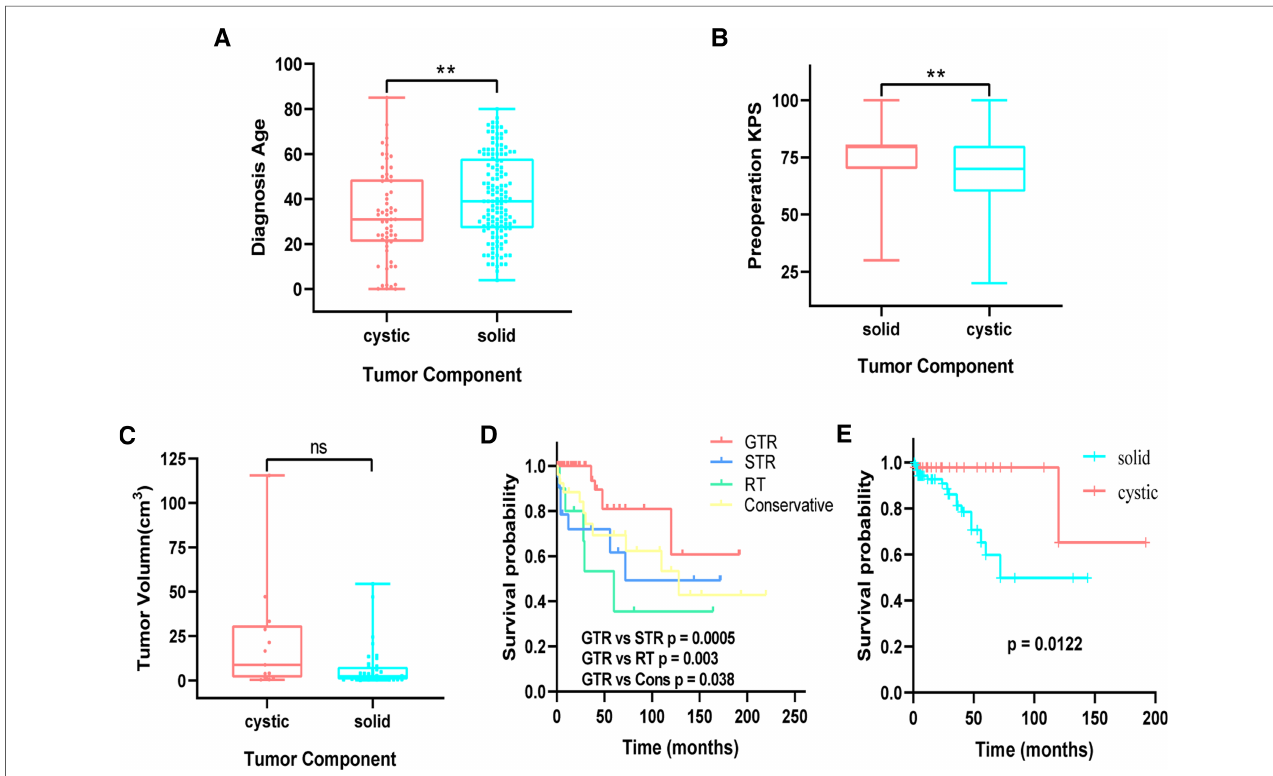
FIGURE 2 ( A ) comparison of age between cystic and solid patients. ( B ) Comparison of preoperation KPS between cystic and solid patients. ( C ) Comparison of cystic and solid tumor volume in purely supratentorial solitary hemangioblastoma. ( D ) Kaplan – Meier analysis of progression-free survival of supratentorial hemangioblastoma strati fi ed by treatment modalities. GTR vs. STR ( p =0.0005), GTR vs. RT ( p =0.003). ( E ) Cystic vs. solid ( p =0.0122). KPS, Karnofsky Performance Scale; STR, subtotal